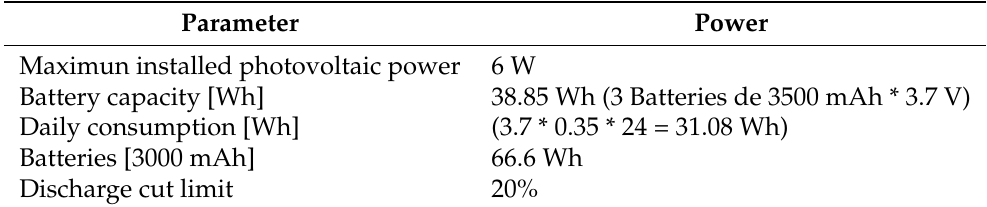
Table 2. Parameters used to simulate the energy charge and discharge